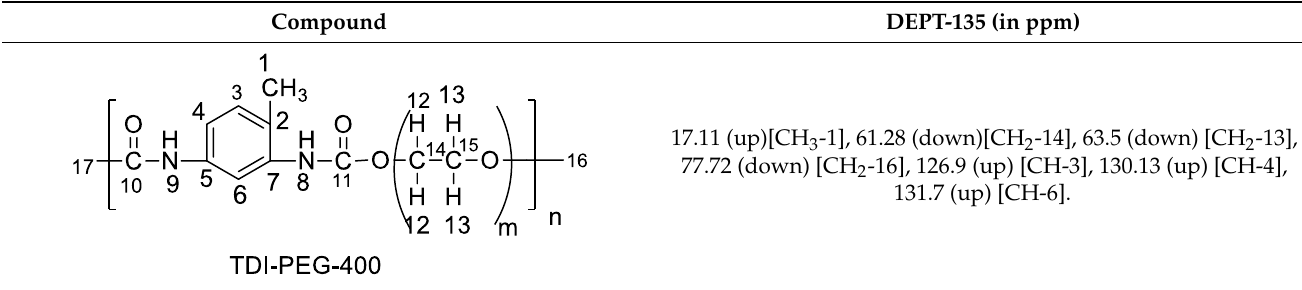
Table 5. DEPT-135 spectral data of polyurethane from 3-(4-bromophenyl)-1H-pyrazole-blocked TDI. Compound